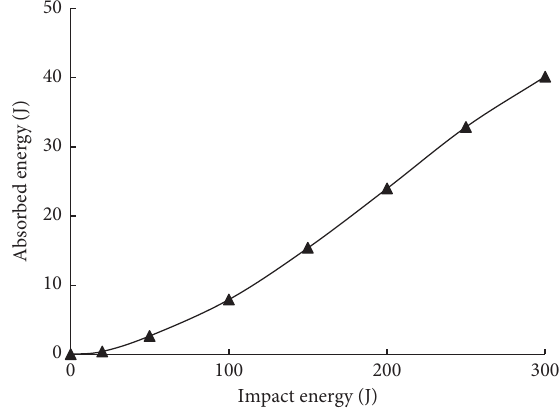
Figure 18: The relationship of the absorbed energy and the impact